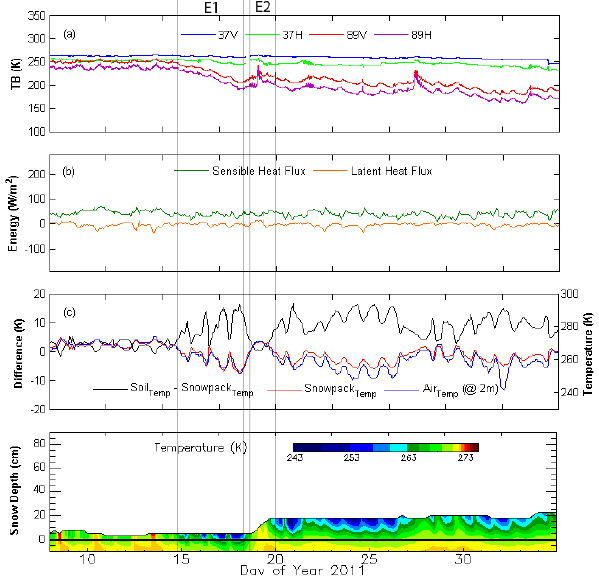
Fig. 3. Time series of observed radiometric and physical character- istics of snowpack snow accumulation phase in early winter period. (a) Microwave brightness temperature at 37 and 89GHz vertical and horizontal polarization, (b) modeled sensible heat flux and la- tent heat flux, (c) snow depth, air temperature at 2m from surface, and integrated average snowpack temperature measured by temper- ature profiler, and (d) temperature measured at different depths be- low and above the ground